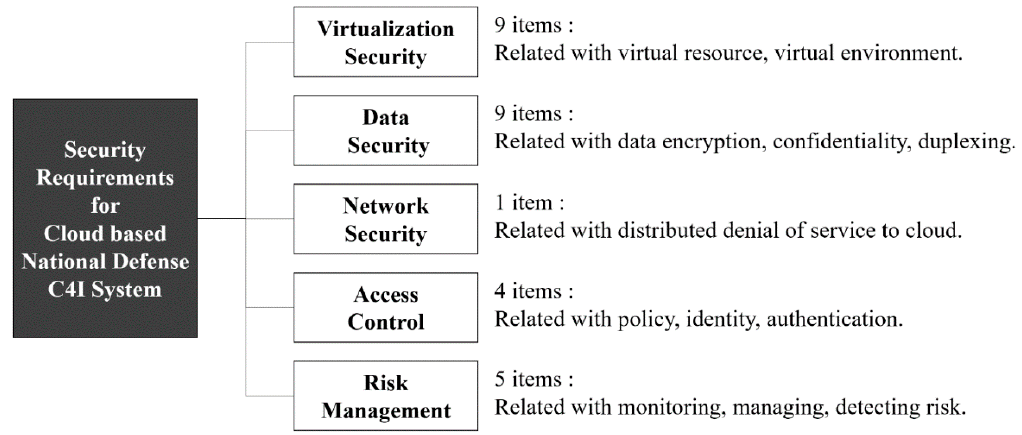
Figure 2. Security Requirements for the Cloud-based National Defense C4I System.